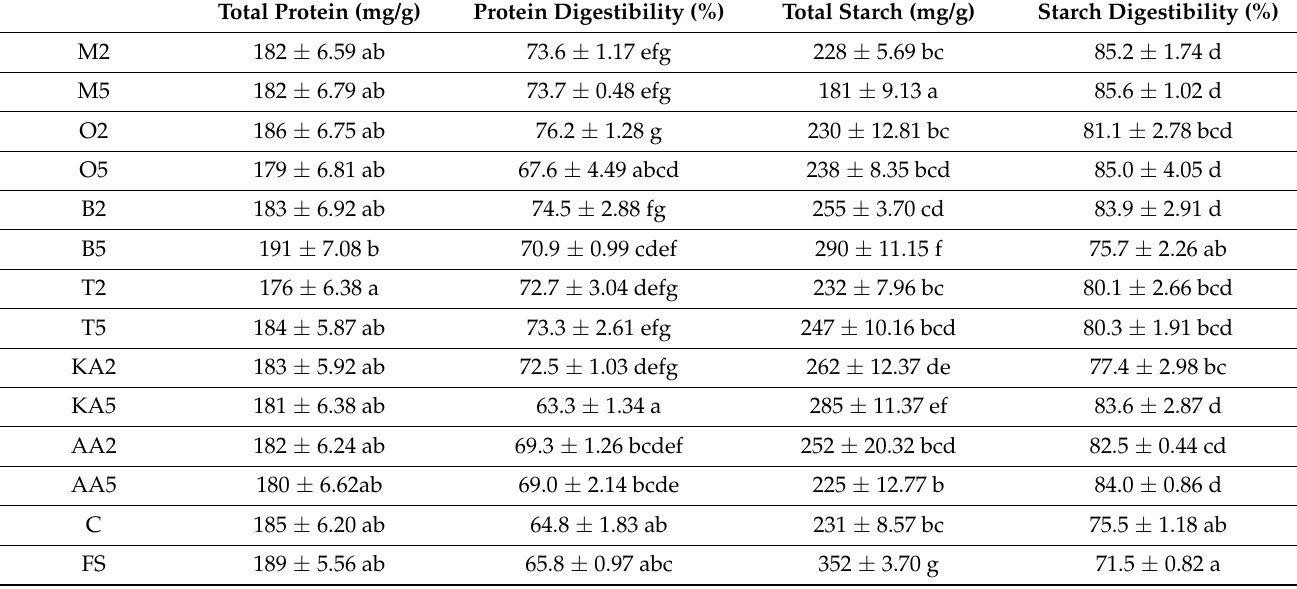
Table 3. Nutritional properties of mung bean sprouts treated with antibrowning